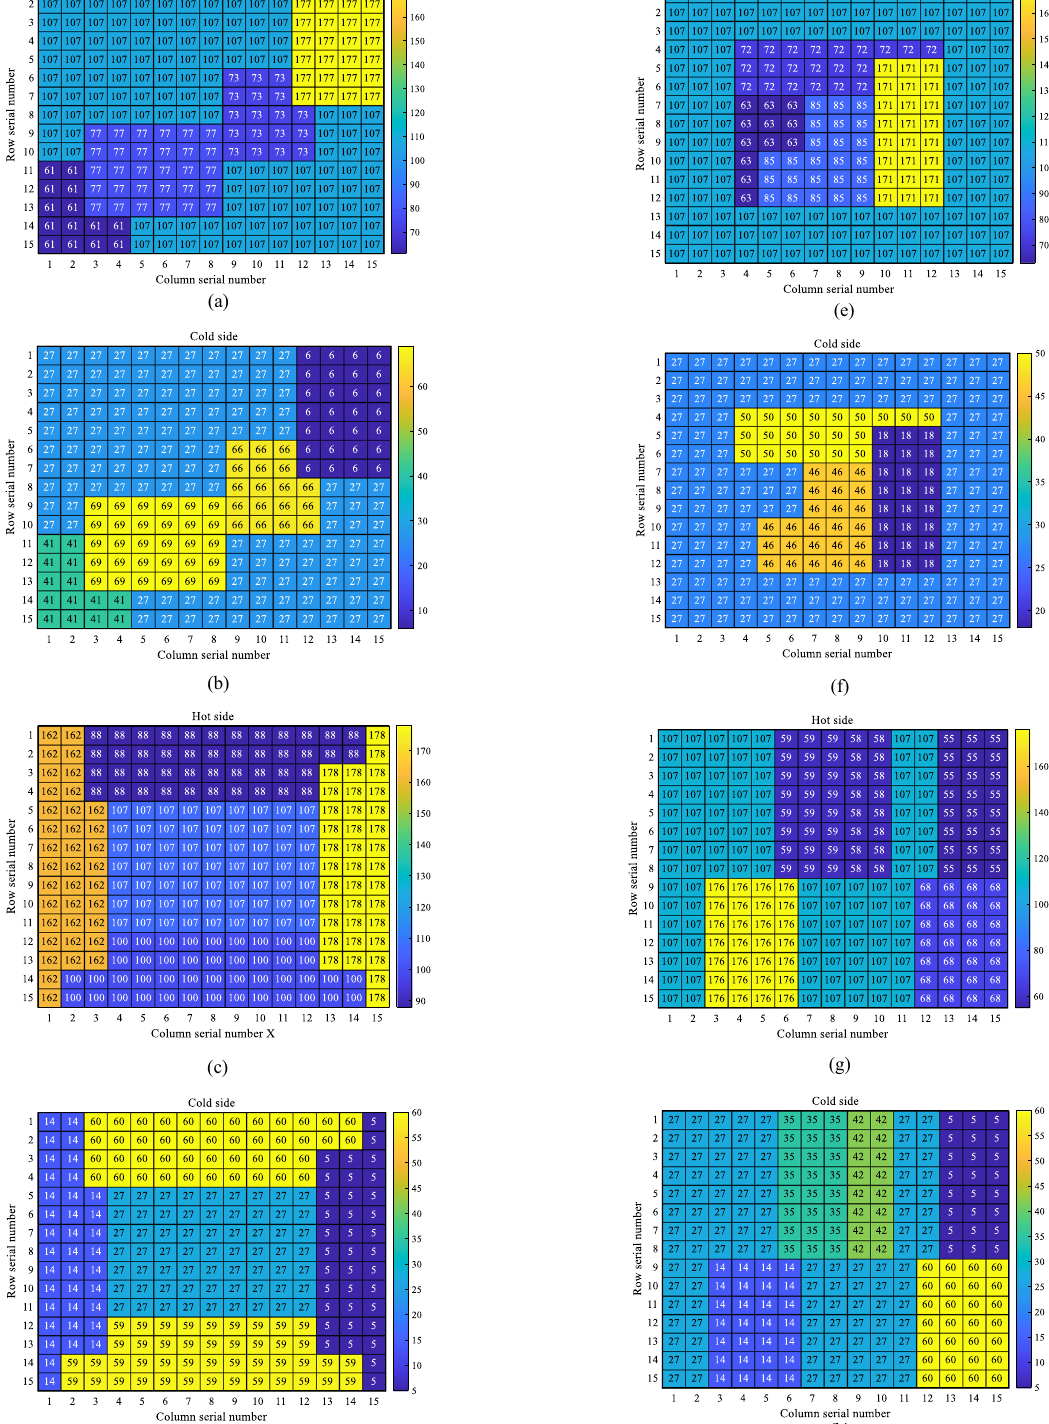
Fig. 5 Initial temperature distribution (°C) of four different scenarios for (15